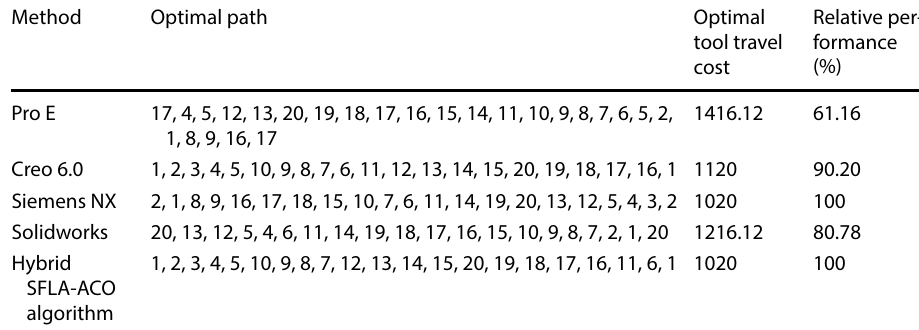
Table 2 Comparison of results Method Optimal